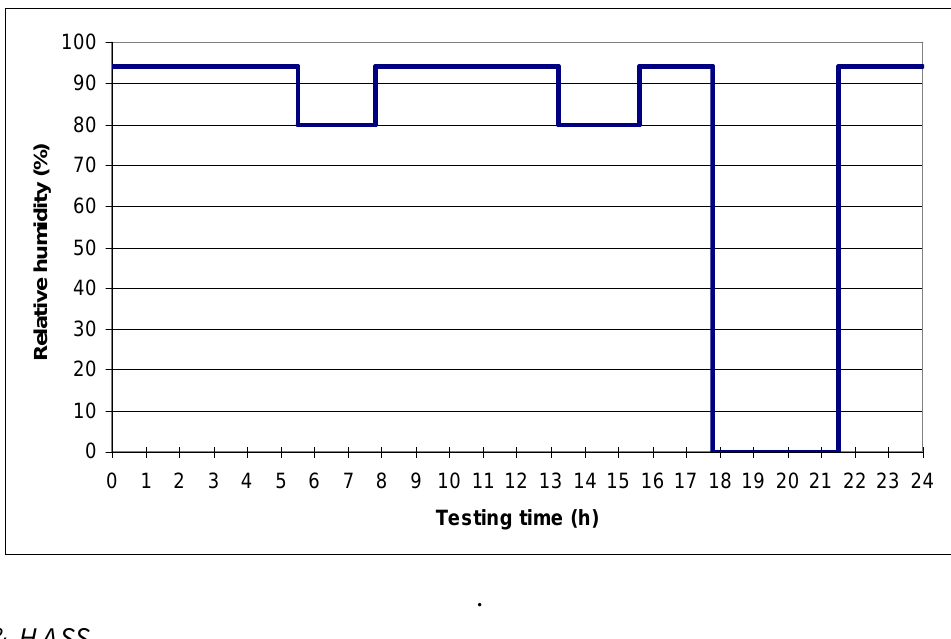
Figure 4. Standard IEC-68-2-38 for